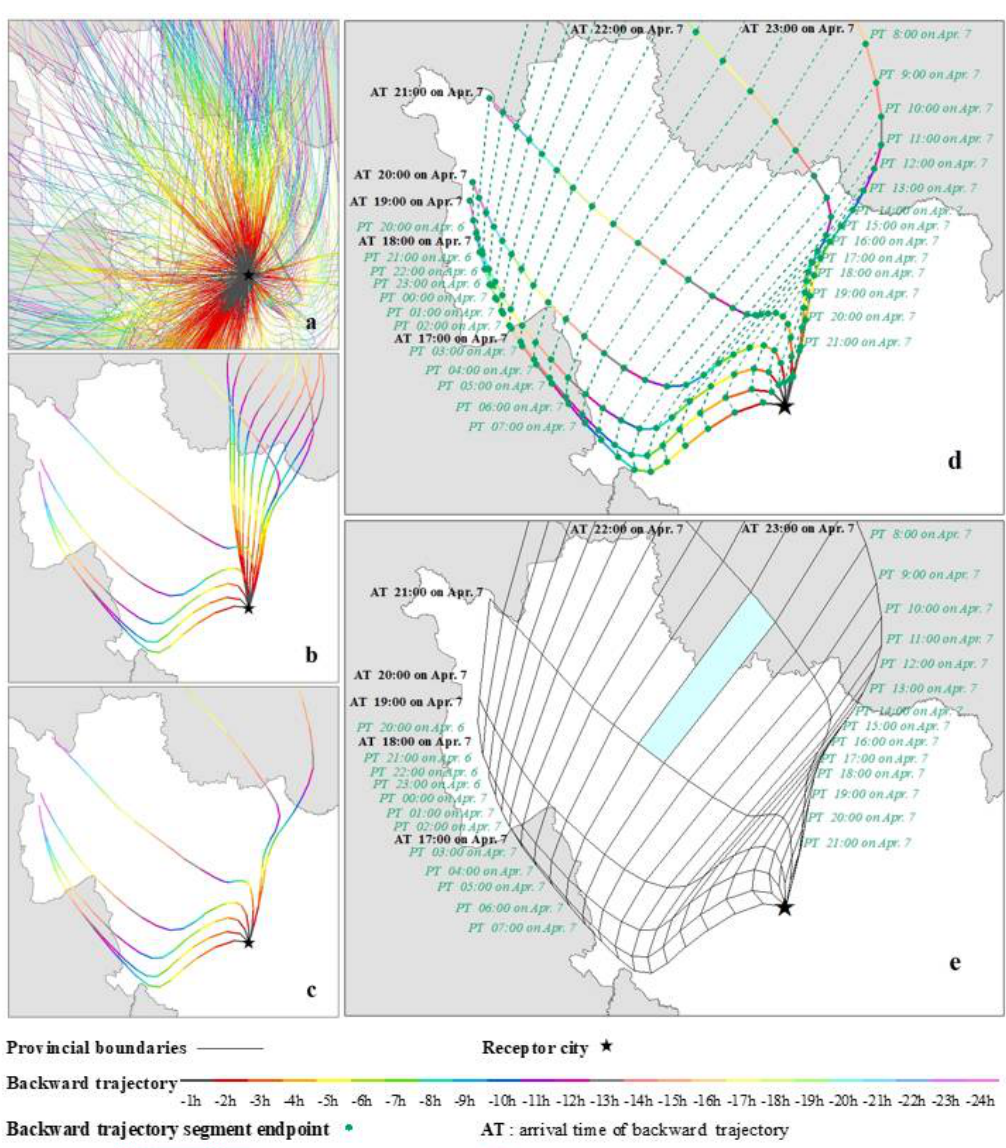
Figure 3. Schematic of reconstructing hourly transport pathways and wind-field grids. Note: ( a ): Hourly backward trajectories with hourly arrival times of April 2021; ( b ): Hourly backward trajectories with hourly arrival times from 17:00 on 7 April to 7:00 on 8 April; ( c ): Hourly backward trajectories with hourly arrival times from 17:00 to 23:00 on 7 April; ( d ): Pathway lines indicating the geographic position of a moving air mass at the same moment as the pathway time; ( e ): Spa- tiotemporal distribution of the wind-field grids, for example, the air mass arriving at receptor city at 22:00 on 7 April 2021 was distributed in the region of the blue grid at 6:00–7:00 on 7 April 2021.